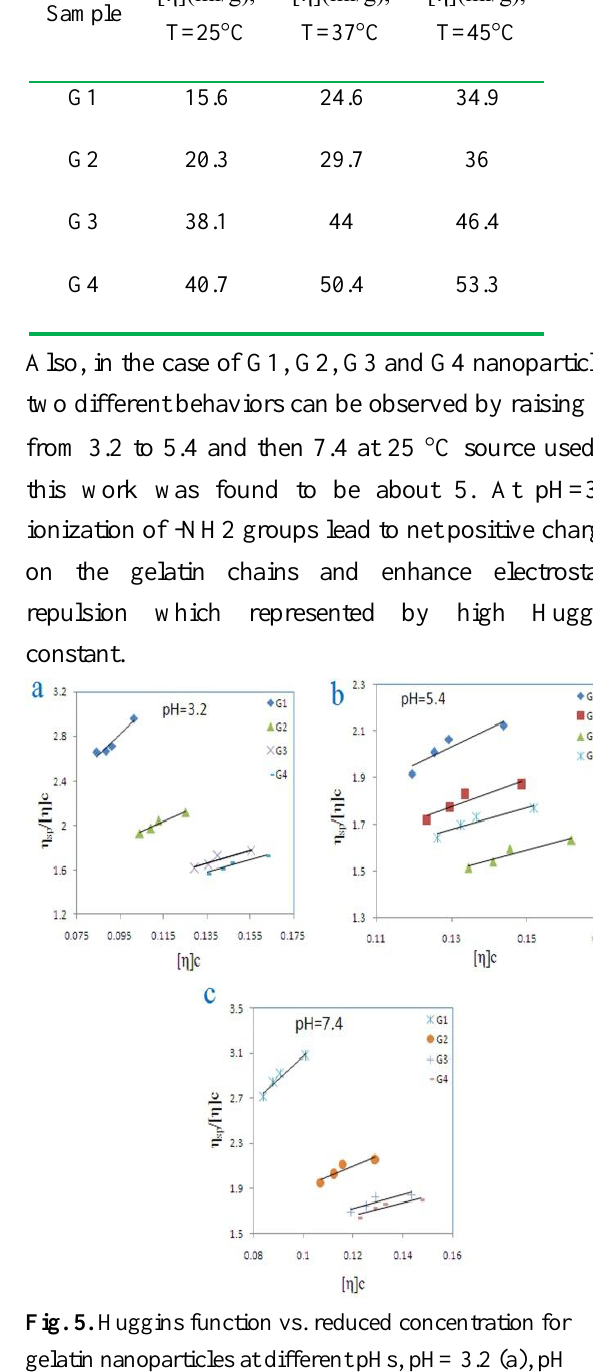
Fig.4. Intrinsic viscositiy vs. temperature for gelatin nanoparticles.